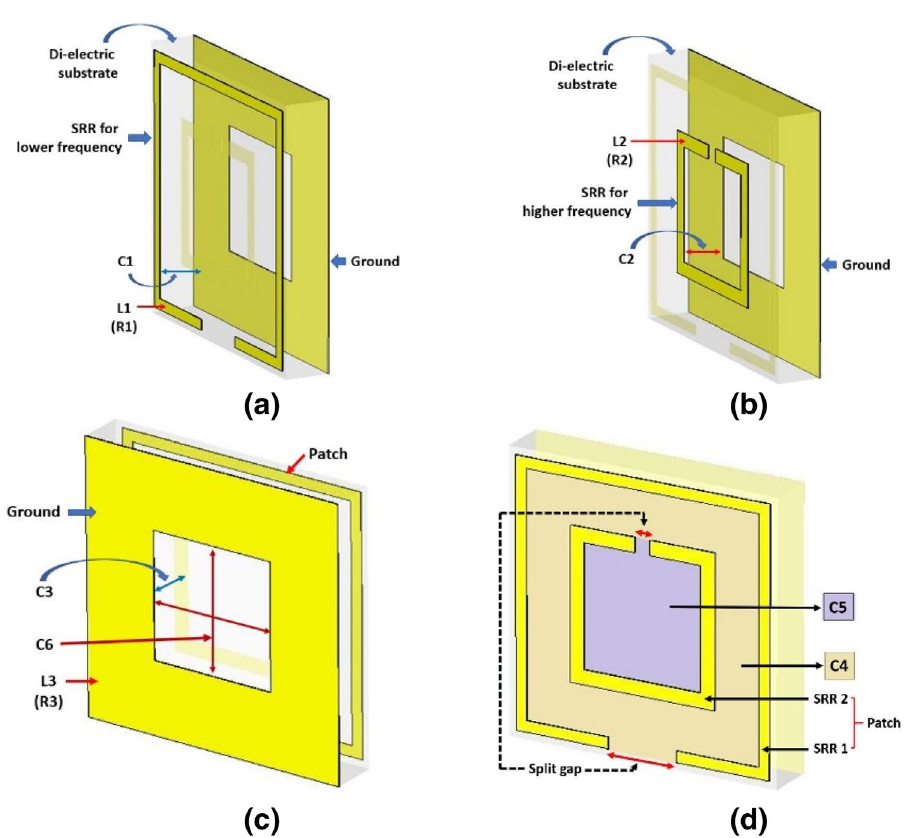
Figure 6. A detailed impression of the L, C, and R in ( a ) the split-ring resonator (SRR) -1 for lower frequency, ( b ) the SRR -2 for the higher frequency, ( c ) the ground; and ( d ) the parallel capacitance due to the bounded surface area by the